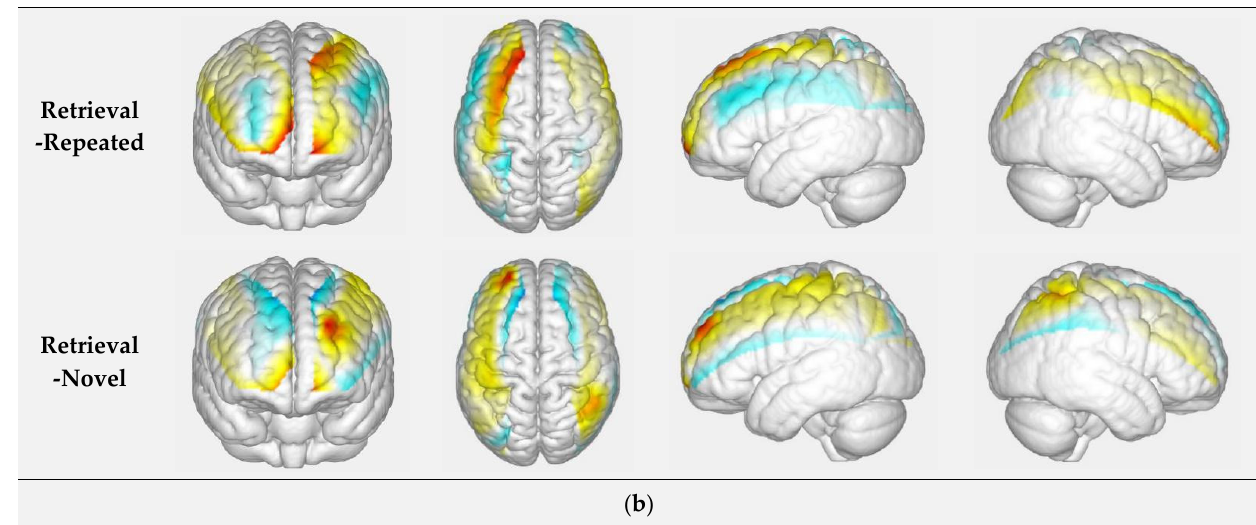
Figure 3. ( a ) Visualization of beta values in the encoding condition; ( b ) visualization of beta values in the retrieval. The warmer color represents a higher beta value (positive), whereas the cooler represents a lower beta value (negative).